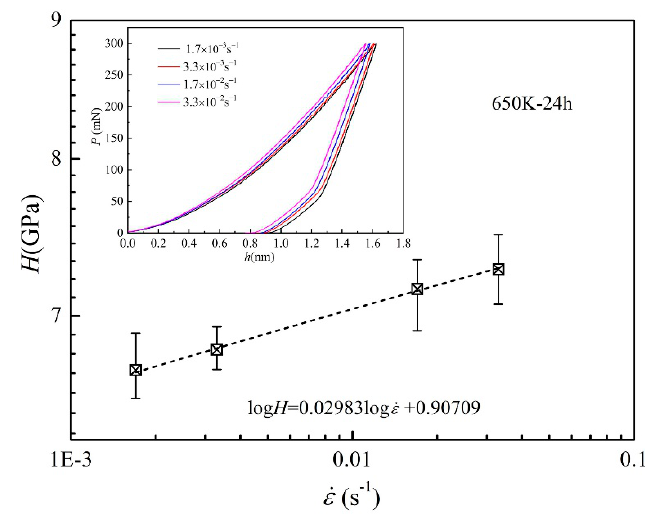
Figure 6. Dependence of hardness on equivalent strain rate in 650 K–24 h annealed sample, the insert presents the representative load–displacement responses under four strain rates.